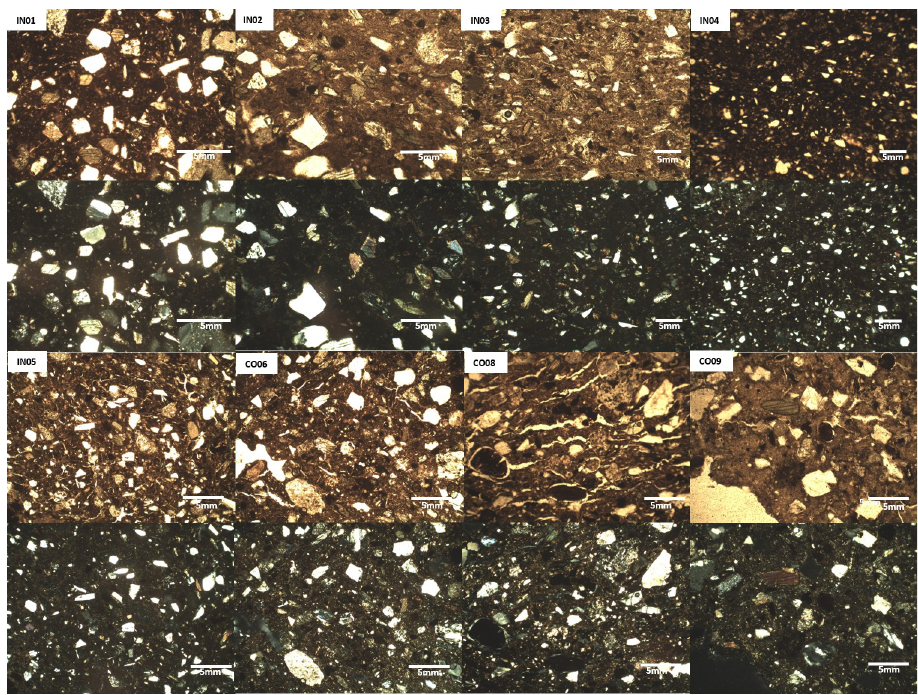
Fig 6. Microphotographs of samples petrographic thin sections. Inguapı´samples[(IN) under PPL and XP and La Cocotera samples (CO) under PPL and XP.